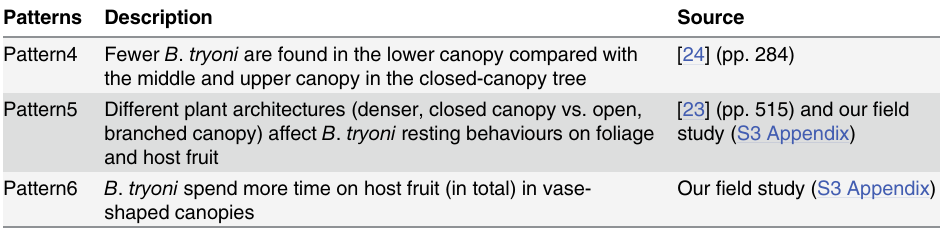
Table 5. The overview of three independent patterns used for the model output